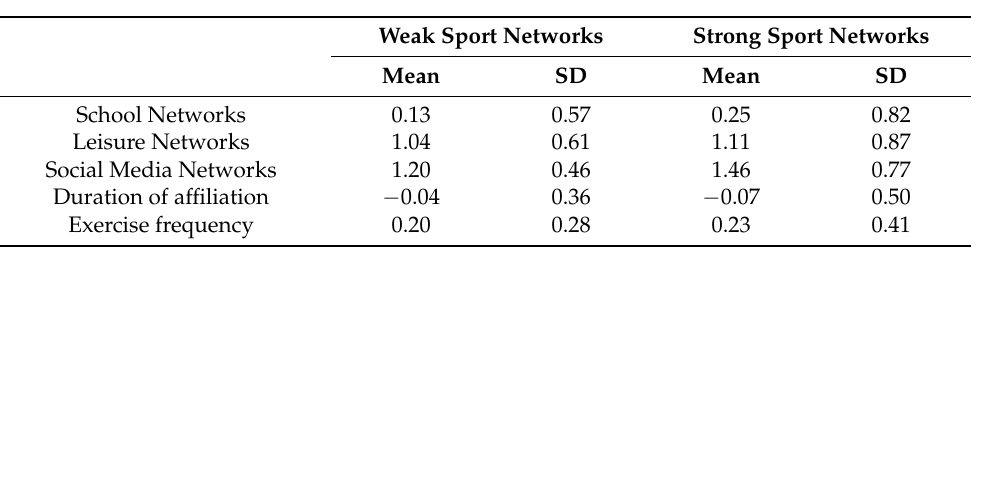
Figure 1. ( a – e ): Coefficients and standard errors ( ± 2) for each of the independent variables in the weak network models. Table 2. Average values for the ERGM coefficients and their standard deviation in the two sport